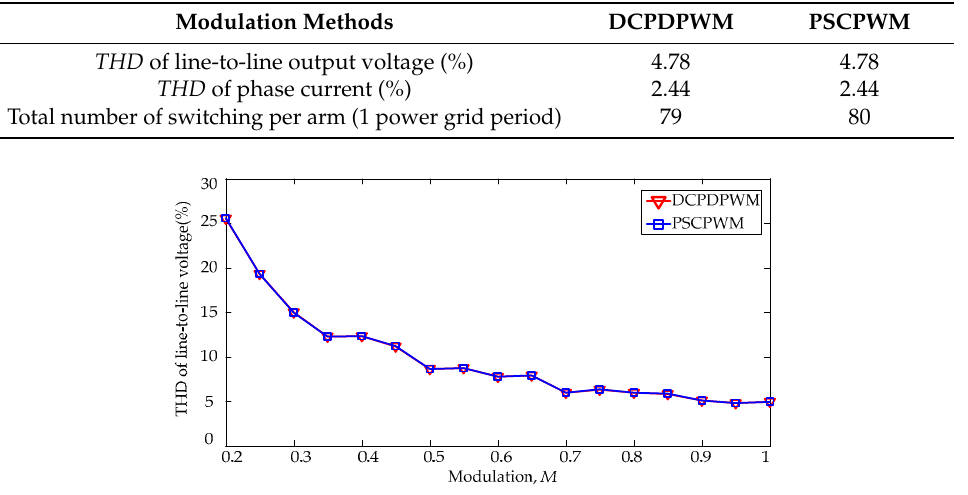
Figure 10. THD of line-to-line output voltage for DCPDPWM and PSCPWM methods in different modulation index with output voltage harmonics minimization scheme.